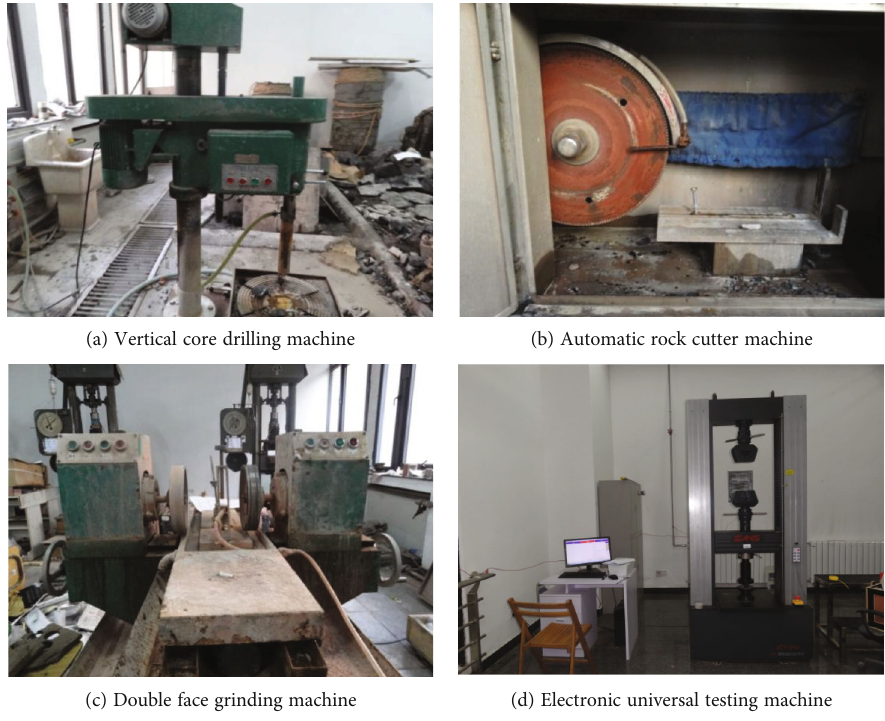
Figure 4: Processing and experiment equipment.